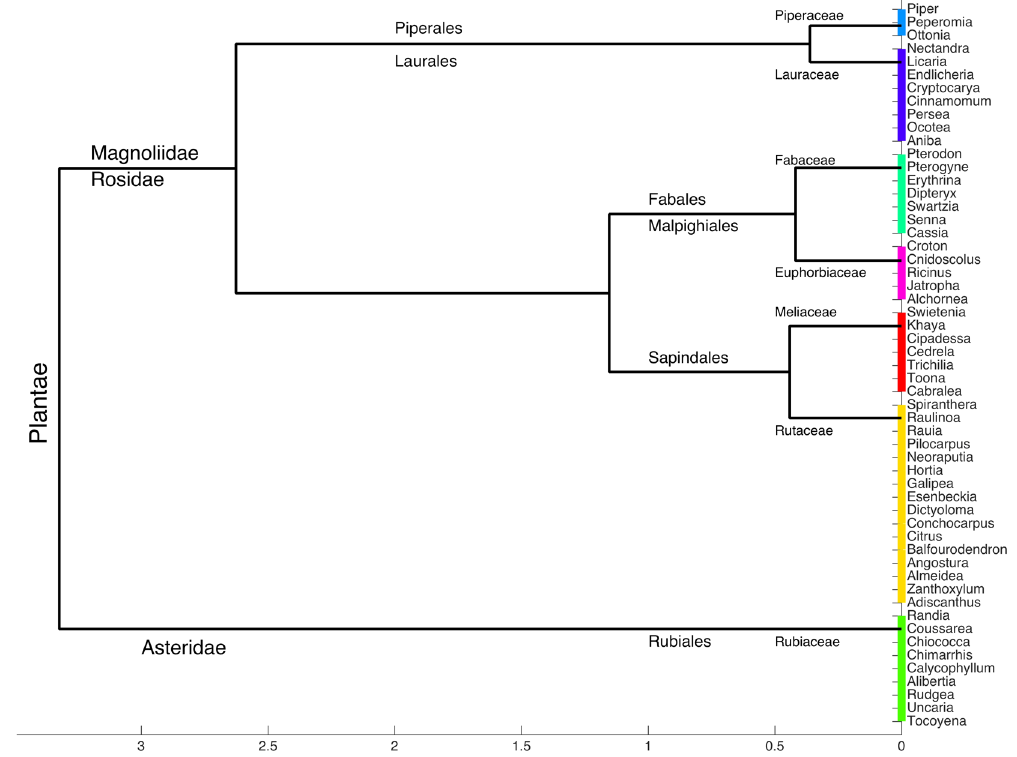
Figure 4. Hierarchical dendrogram representing the taxonomic structure (classes, orders, families and genera) of the most frequently reported species from which the compounds in the NuBBE DB were